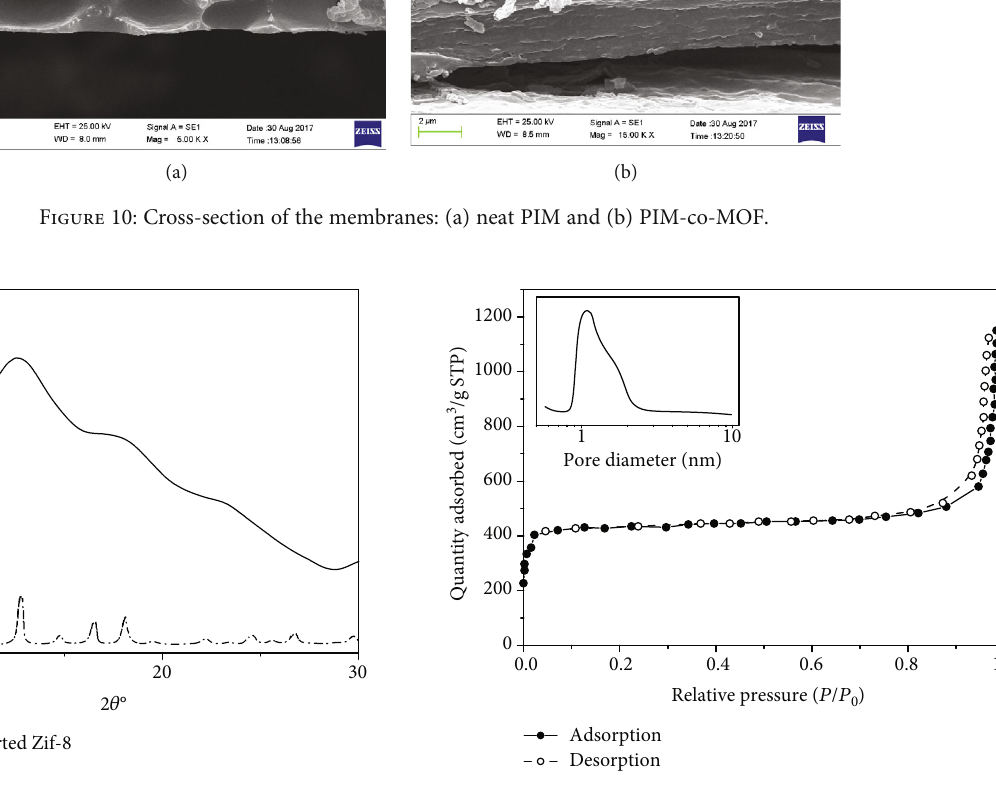
Figure 11: XRD spectra of Zif-8 deposited on the PIM surface. Figure 12: N 2 adsorption-desorption isotherms of the Zif-8 supported